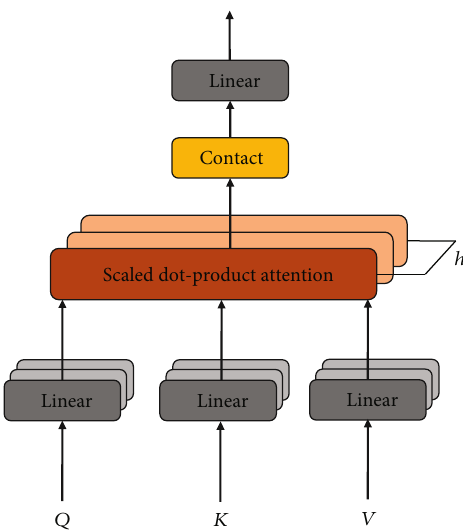
Figure 4: Multiheaded attention network.